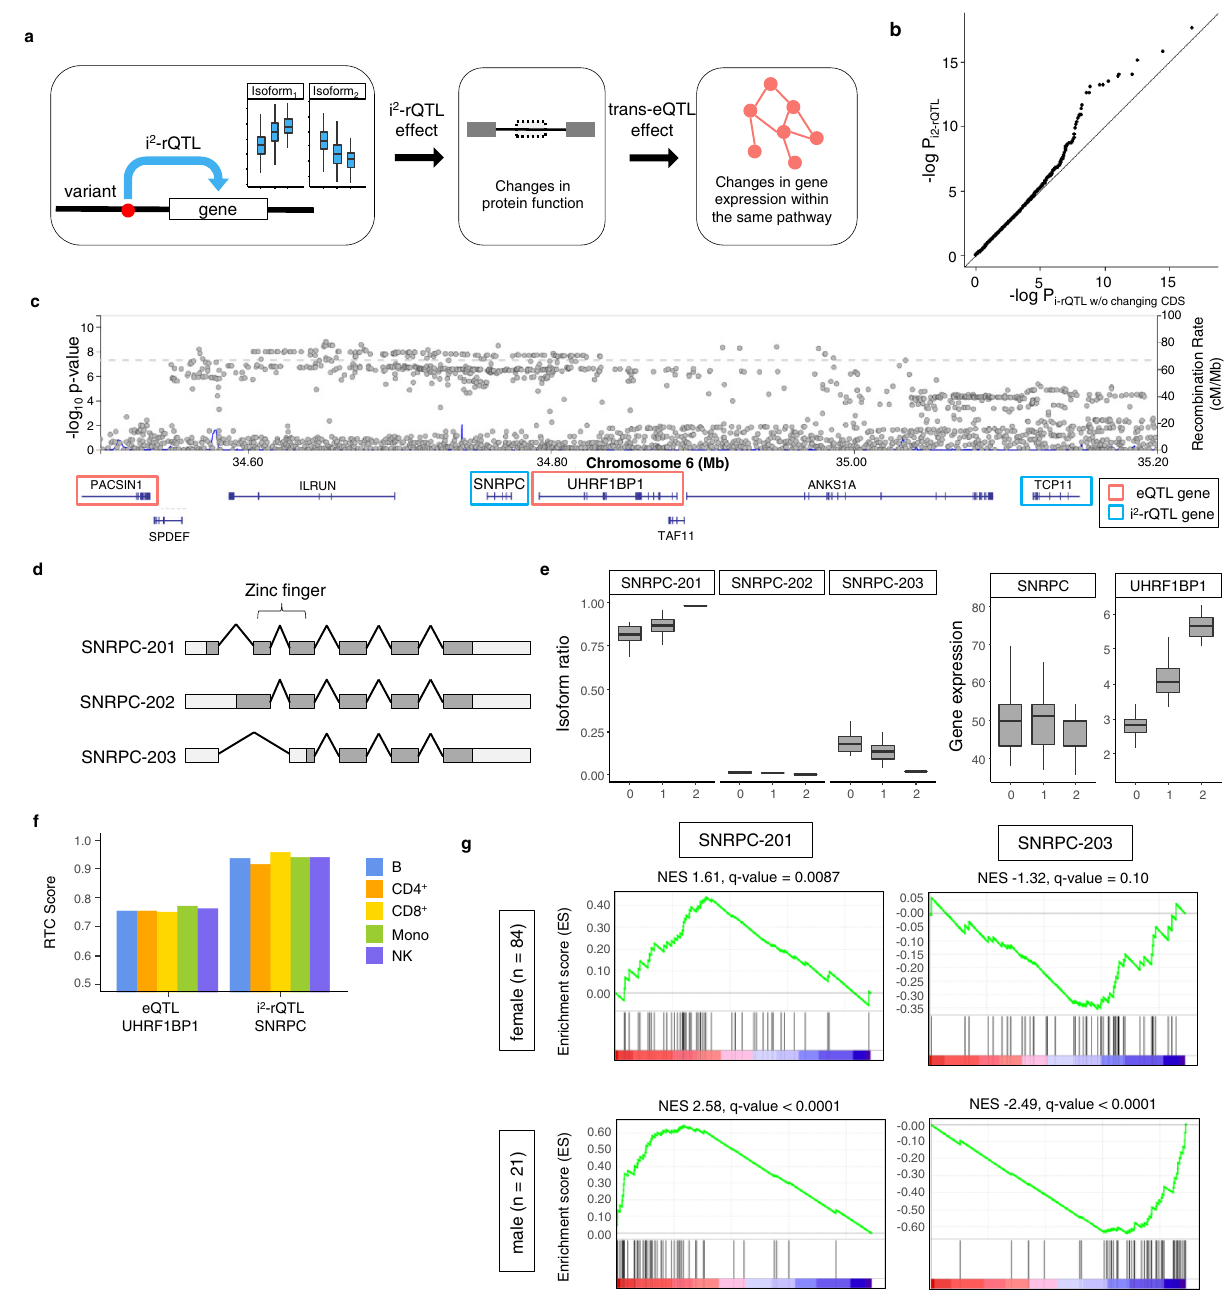
Fig.6 |Identi fi cationofcausalgenesusing trans-eQTLanalysisatgenomicloci with multiple eQTL and i 2 -rQTL effects. a Schematic diagram of how an i 2 -rQTL effect leads to a trans-eQTL effect. b Comparison of trans-eQTL p -values of i-rQTL variants and those of i 2 -rQTL variants. c The SNRPC-UHRF1BP1 locus forms a large linkage disequilibrium block and contains multiple eQTL or i 2 -rQTL genes. d Gene models of major protein coding isoforms of the SNRPC gene. e i 2 -rQTL effects on